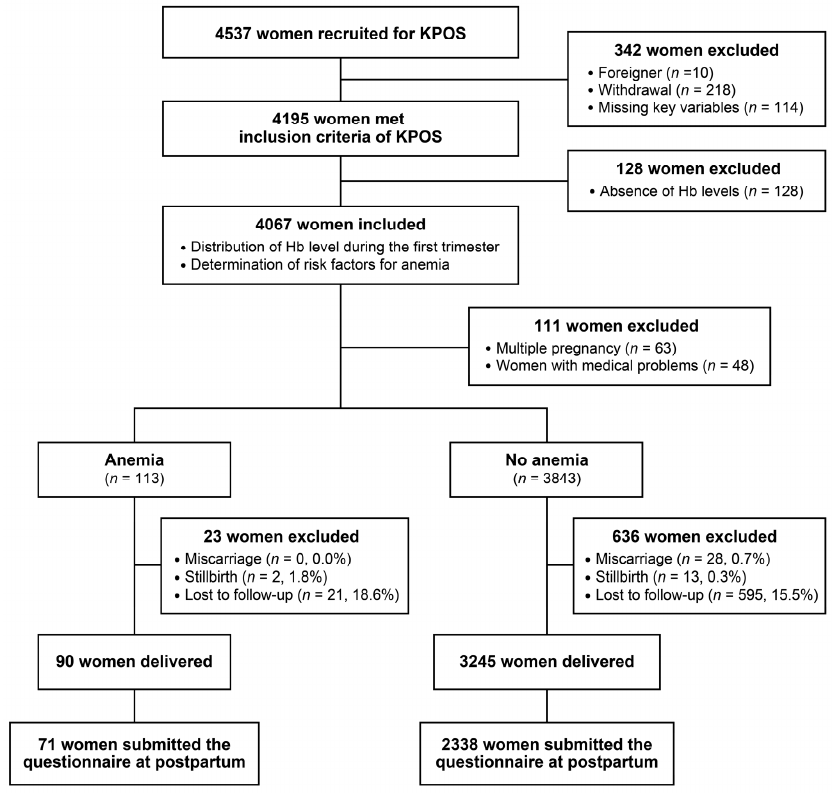
Figure 1. Flow diagram of this study. Hb—hemoglobin; KPOS—Korean Pregnancy Outcome Study; Miscarriage—fetal death before the 20th week of gestation; Stillbirth—fetal death after the 20th week of gestation.